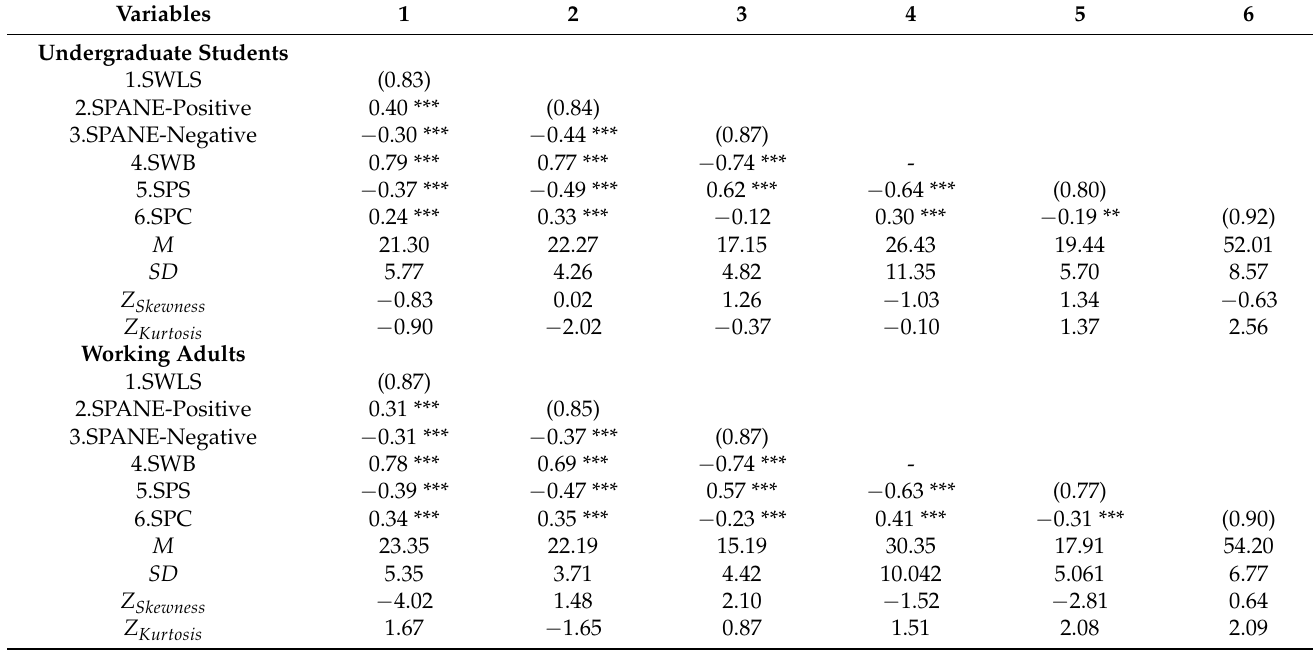
Table 1. Means, Standard Deviations, Correlation, and z values of Skewness and Kurtosis Among Variables for Study 1.